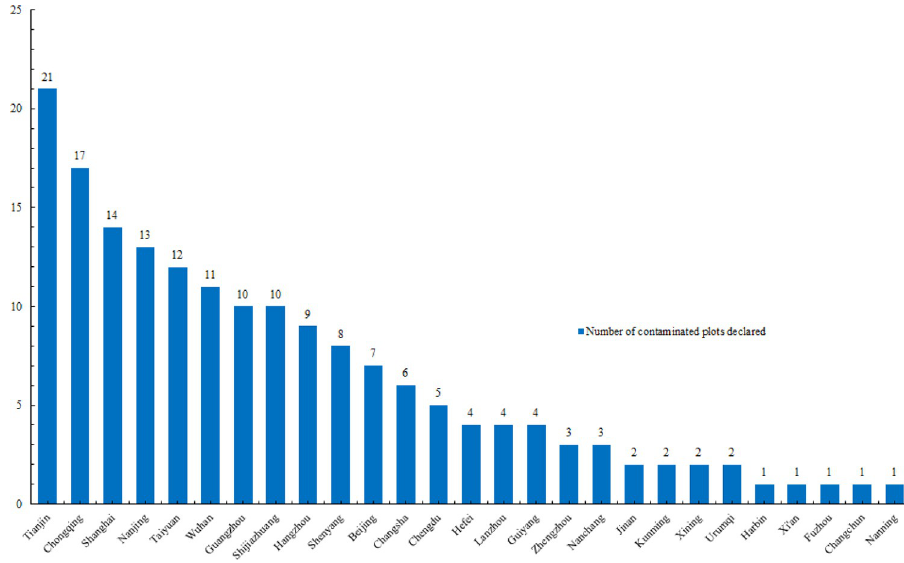
Fig 5. Announcement of contaminated land in major provincial capitals in China.